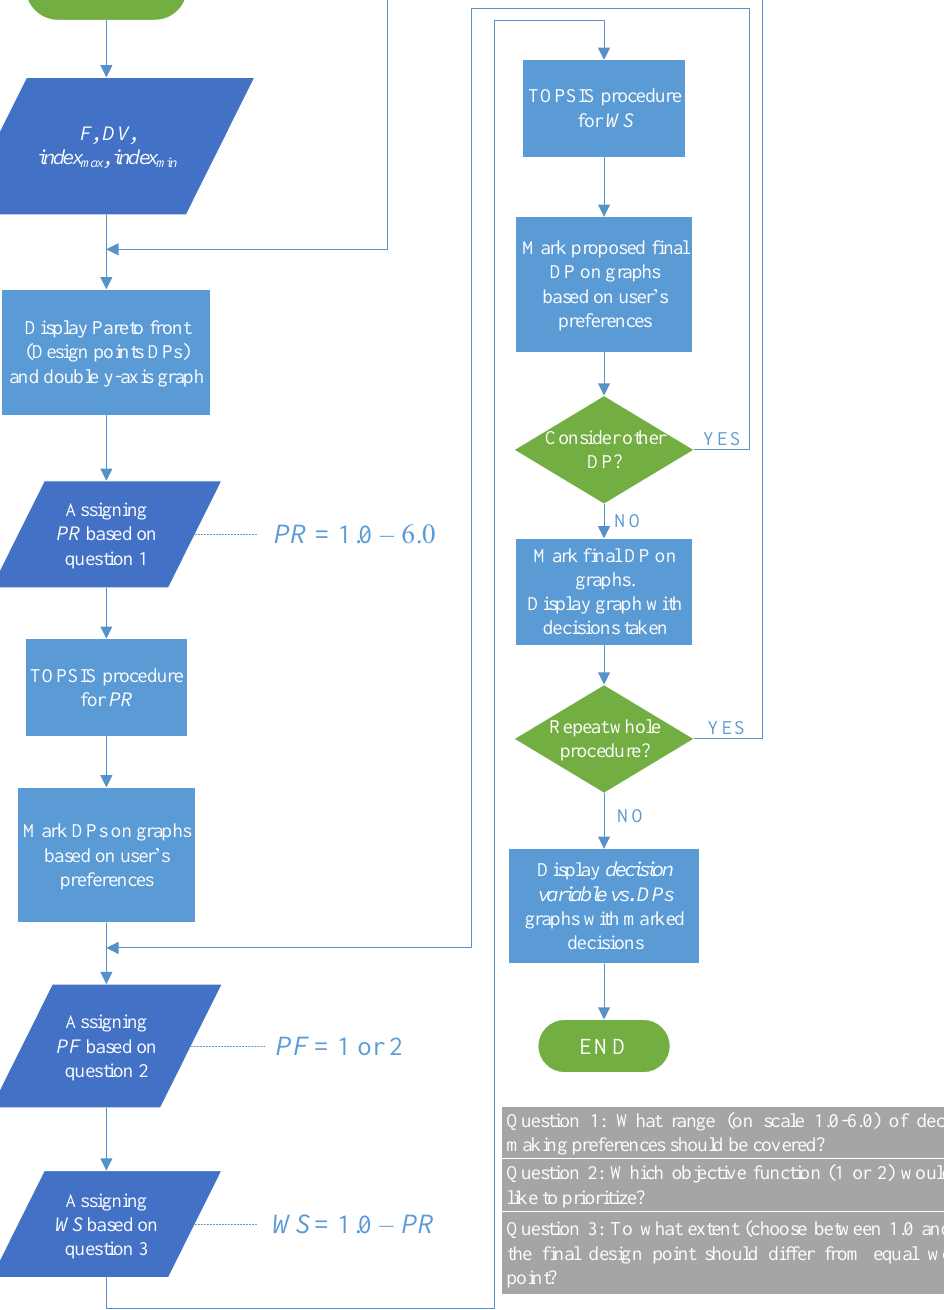
Figure 5. Flowchart of the proposed decision-making procedure.